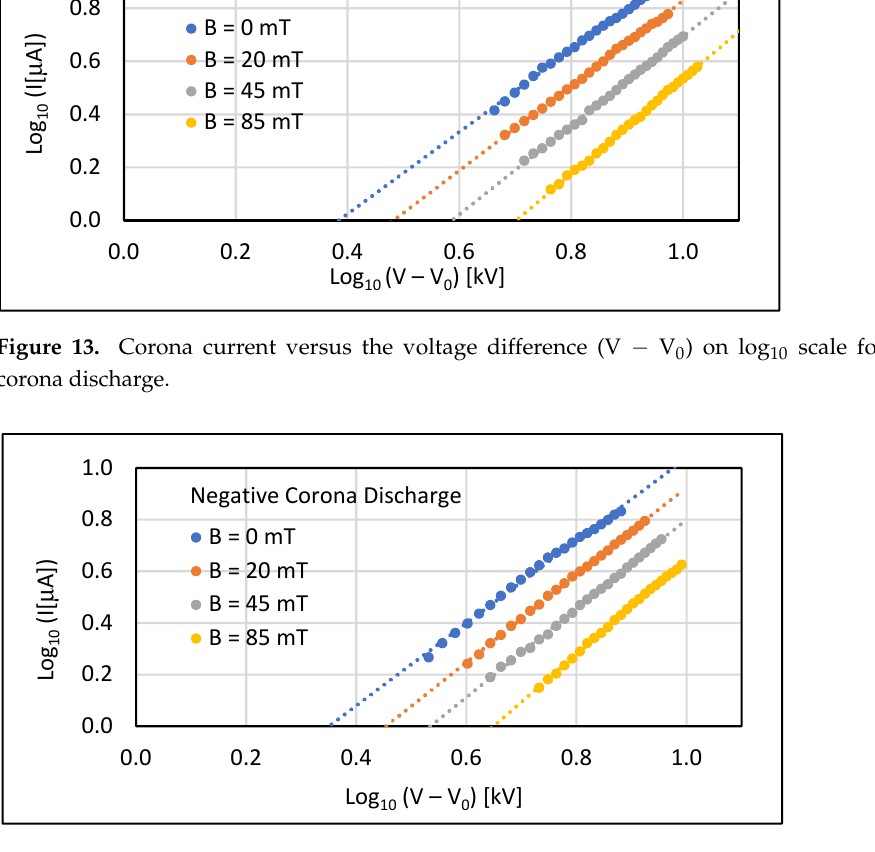
Figure 14. Corona current versus the voltage difference (V − V 0 ) on log 10 scale for negative corona discharge. Table 3. The extracted values of the exponent n and the geometrical factor K for both discharge polarities.